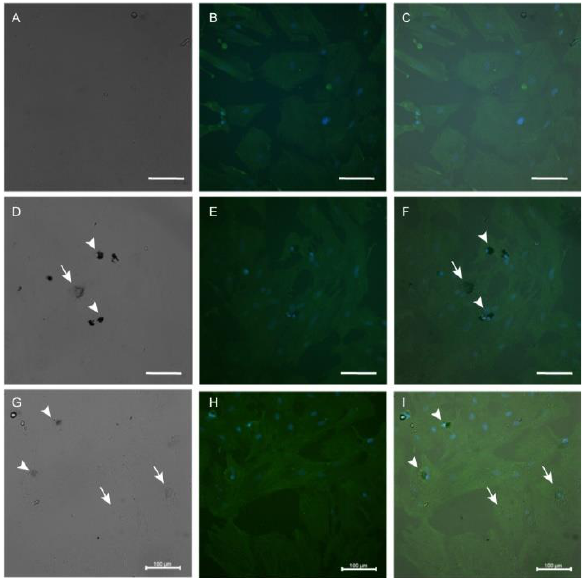
Figure 9. Immunolabeling of β -actin of Adipose-derived stromal cells with 1 week of recovery after 24-h incubation with LA-AuNPs, with uptake and retention of nanoparticles: control ( A – C ), 2 nm LA-AuNPs 1:1 ( D – F ), 53 nm LA-AuNPs 1:1 ( G – I ), on corresponding bright field ( A , D , G ), fluorescence ( B , E , H ), and merged ( C , F , I ) images. Uptake of LA-AuNPs of both sizes were observed as a black cluster in the area adjacent to the nucleus (arrowhead), or more evenly distributed as small clusters in the cytoplasm (arrows). Immunolabeling of β -actin with FITC (green), and nuclei marked with Hoechst (blue). Objective 40x, scale bars 100 µm.